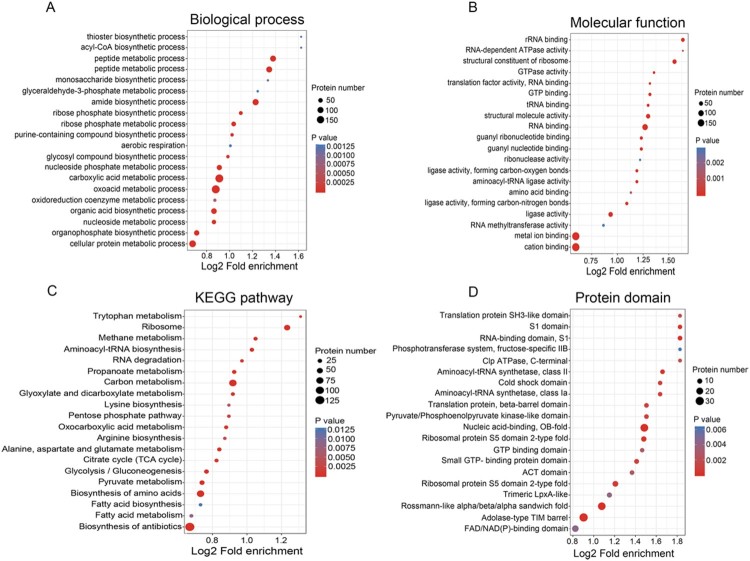
Bubble plot showing the enrichment for GO, KEGG pathway, and Pfam domain of acetyl-proteins. (A and B) GO classification of the identified acetylated proteins in terms of biological process and molecular function. (C) KEGG pathway-based enrichment analysis of acetylated proteins. (D) Pfam domain enrichment analysis of the identified proteins.